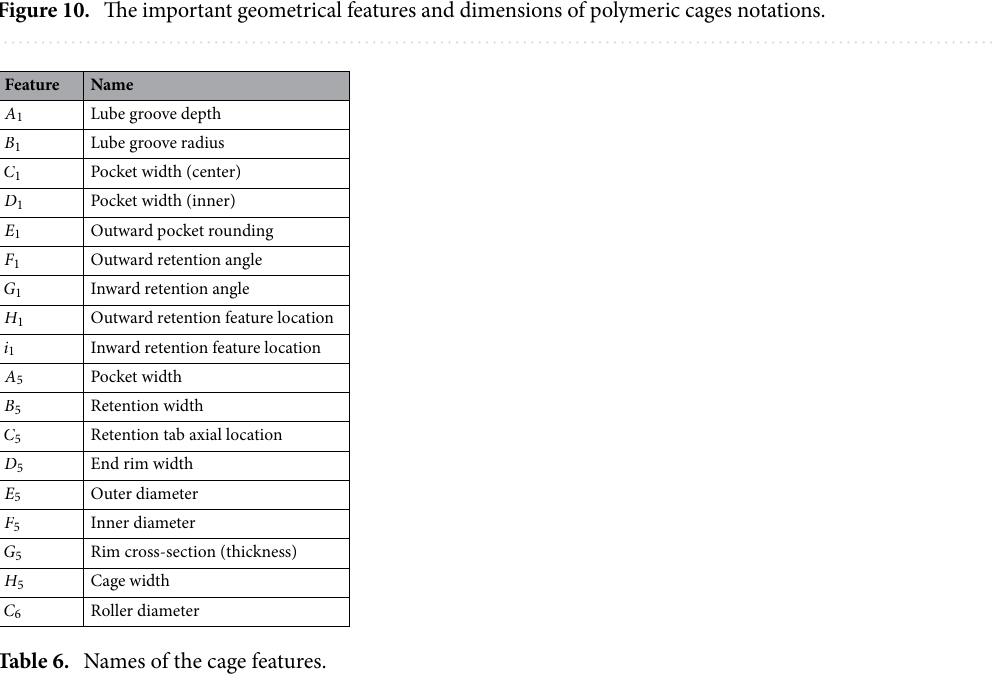
Figure 10. The important geometrical features and dimensions of polymeric cages notations.